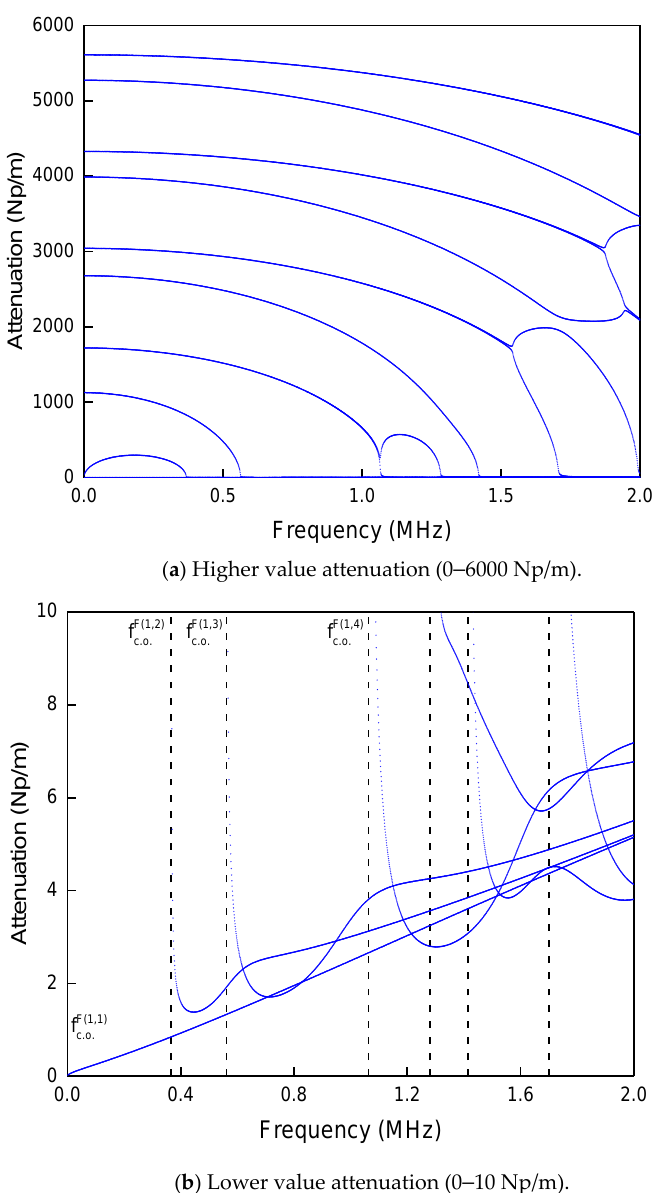
Figure 5. Attenuation curve: ( a ) Higher value attenuation (0 – 6000 Np/m); ( b ) lower value attenuation (0 – 10 Np/m).